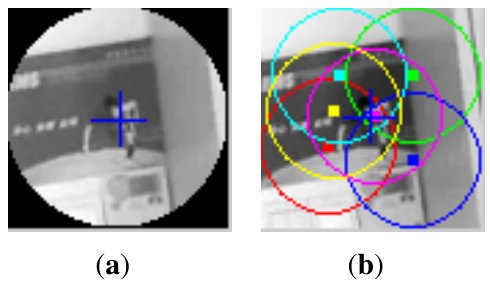
Figure 10. Target templates of the real-life video. ( a ) template of the OMS/SOAMST/SMS; ( b ) subtemplates distribution of the proposed